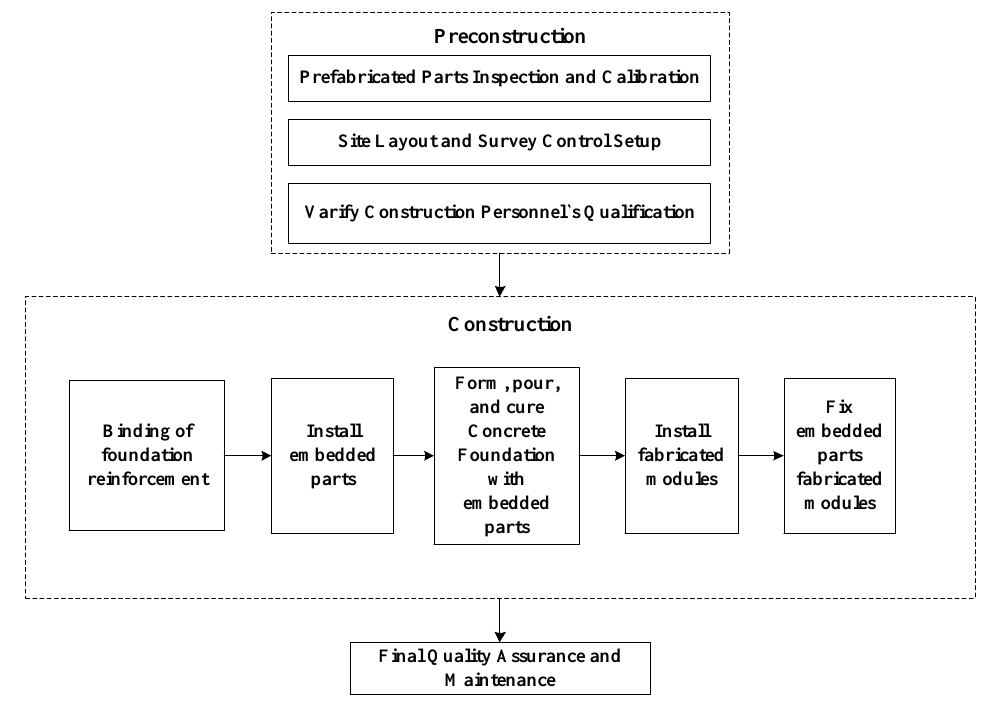
Figure 2. Modular installation and quality control process.